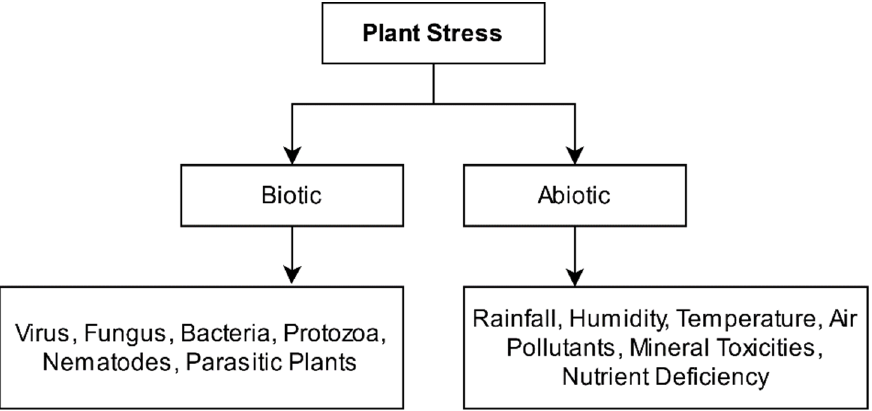
Figure 1. Types of plant stress.